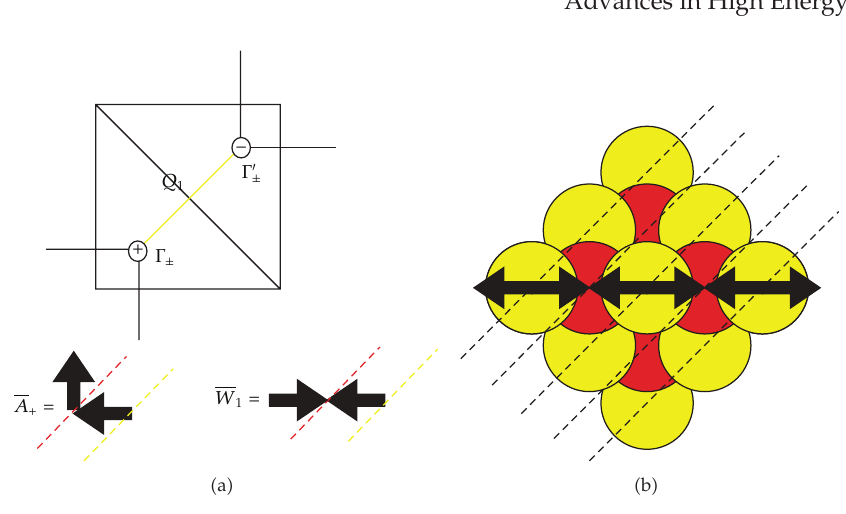
Figure 12: (cid:4) a (cid:5) : toric diagram for the conifold and arrow representation of A (cid:9) and W 1 . (cid:4) b (cid:5) : for chambers with negative R and positive n − 1 < B < n the crystals are given by finite pyramid partitions with n − 1 additional corners, represented by n − 1 stones in the top row (cid:4) the figure shows the case n (cid:7) 4 (cid:5) . The (cid:10) generating function is given by Z n | 1 (cid:7) (cid:18) 0 | (cid:4) W 1 (cid:5) n | 0 (cid:15) which reproduces the result (cid:4) 2.27 (cid:5)